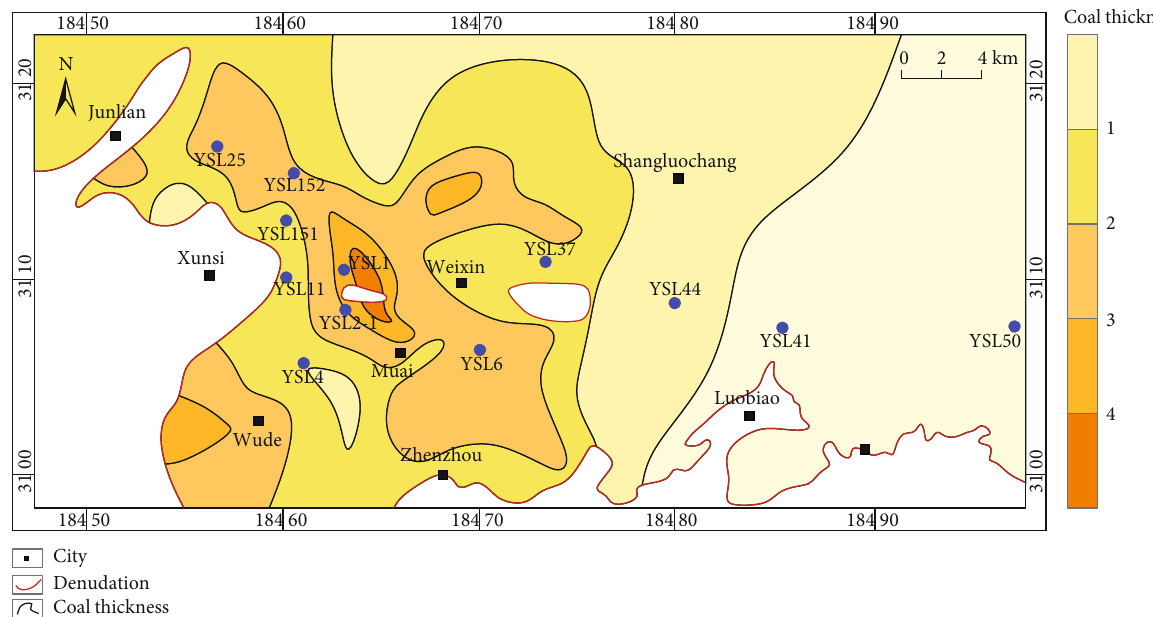
+ C Figure 7: C 2 3 seam thickness contour of